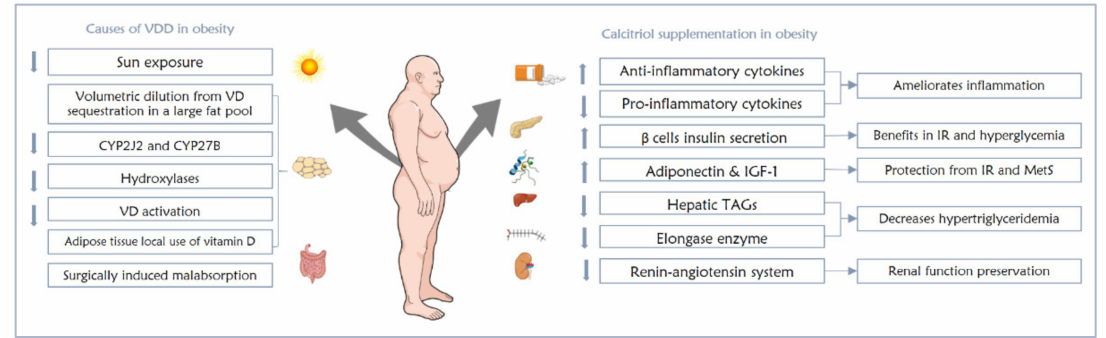
Figure 2. The interrelation between VDD and obesity and the effects of calcitriol supplementation on obese